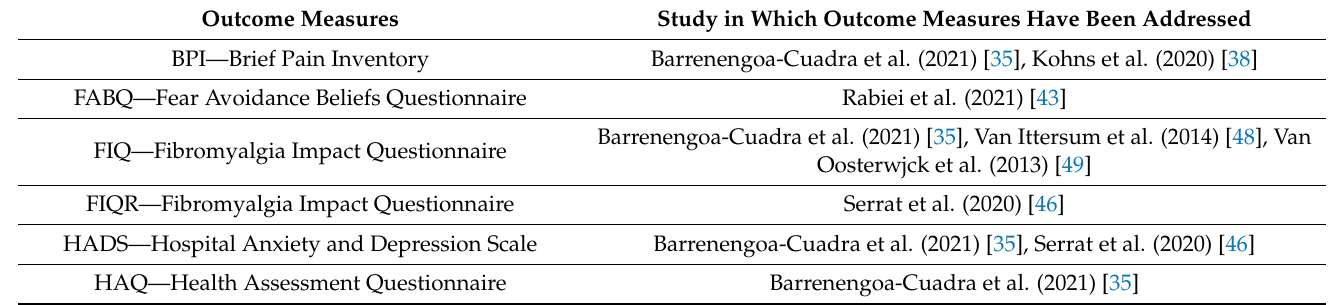
Table 3. Outcome and outcome measures in the included